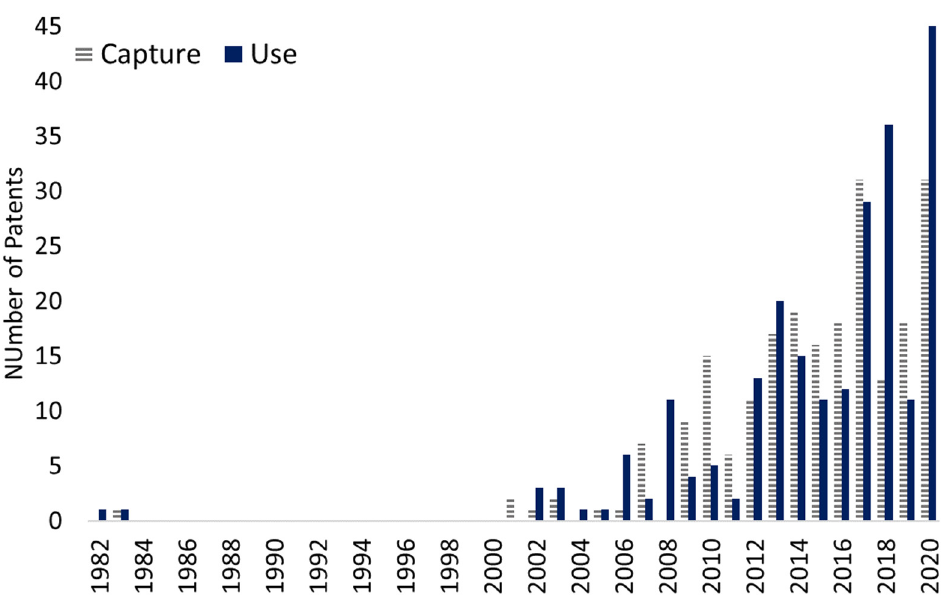
Figure 8. Distribution of published patents regarding carbon capture and use.